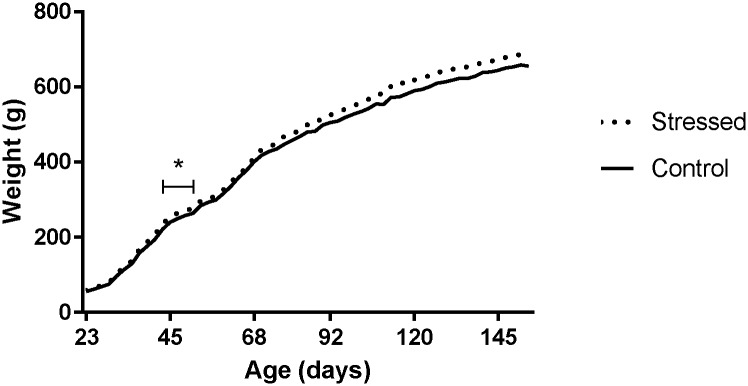
Weight gain throughout life course.The mean weight for the stressed group (dashed line, n = 14) and control group (solid line, n = 16). Weight gain differed during the stress period (PND45-51), with the stressed rats gaining significantly less weight than control rats (*p<0.05). Weight gain did not differ between groups at any time following the adolescent stress period.